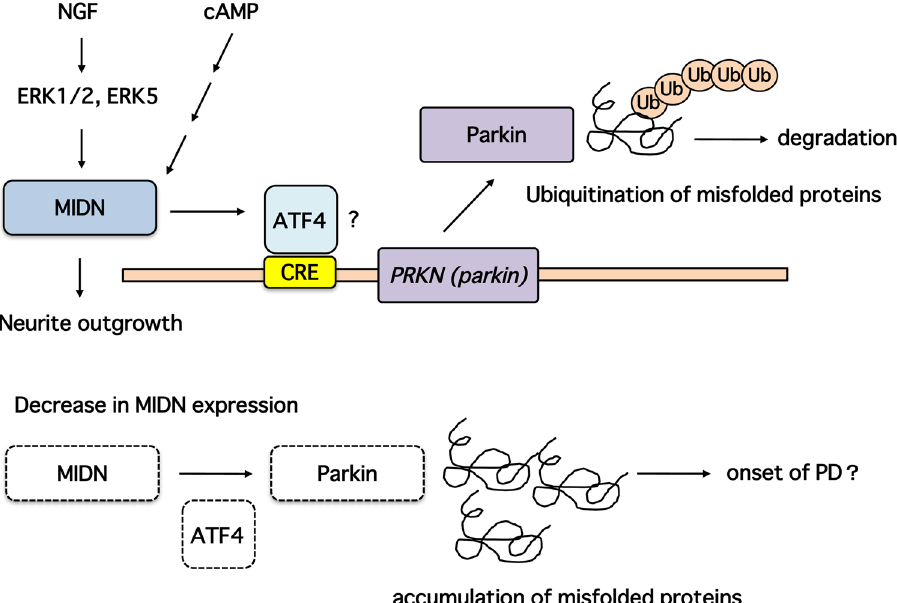
Figure 7. A putative signaling pathway of parkin expression induced by MIDN. Under normal conditions, MIDN is upregulated by both NGF, via ERK1/2 and ERK5, and cAMP signaling. MIDN then promotes neurite outgrowth. Parkin gene expression is promoted by MIDN and ATF4 via the CRE binding site in the parkin core promoter. Parkin then promotes the ubiquitination of misfolded proteins and maintains protein quality. Conversely, when MIDN is down-regulated, ATF4 expression levels also decrease, causing a down-regulation of parkin and a consequent accumulation of misfolded proteins, which can act as a trigger for